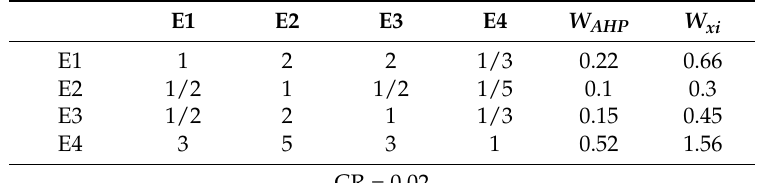
Table 4. The weights estimated from the analytical hierarchy process model and the final weights for the indicators of the exposure factor. For the definition of E1, E2, E3 and E4, see Table 2.